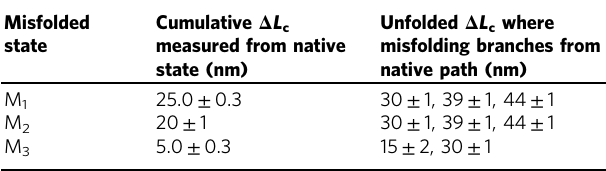
The cumulative Δ L c measured with respect to the native state (i.e., length of unfolded polypeptide) is shown for each misfolded state, and for each of the intermediates at which a misfolded state branches off from the native folding pathway. All values expressed as mean ±